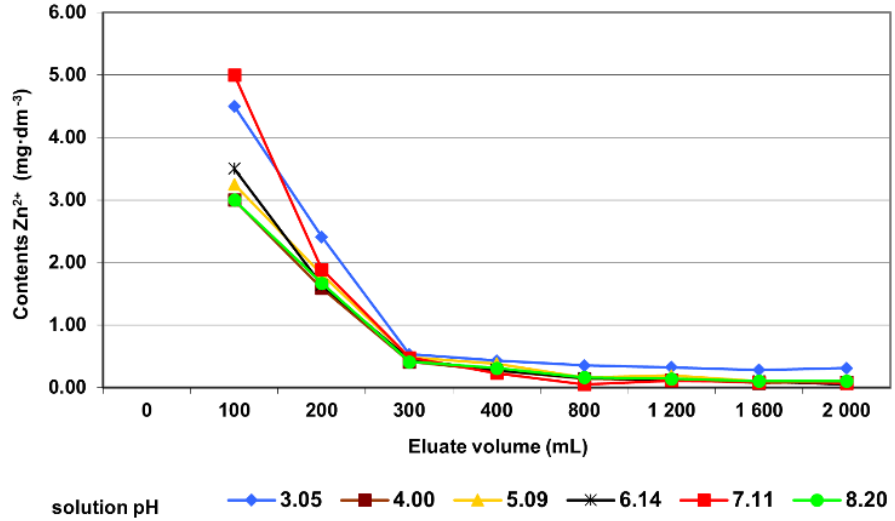
Figure 4. Contents of Zn 2+ ions in successive portions of the collected eluate depending on the pH of the initial leaching solution.